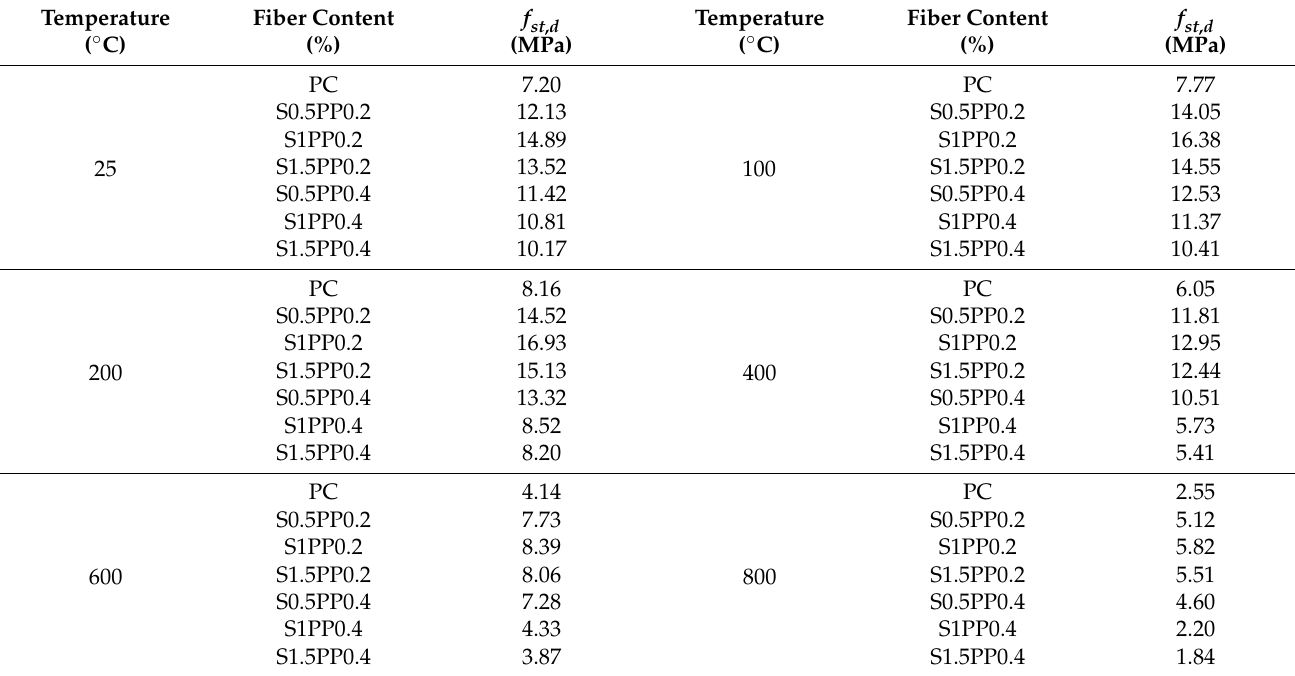
Table 4. Summary of experimental